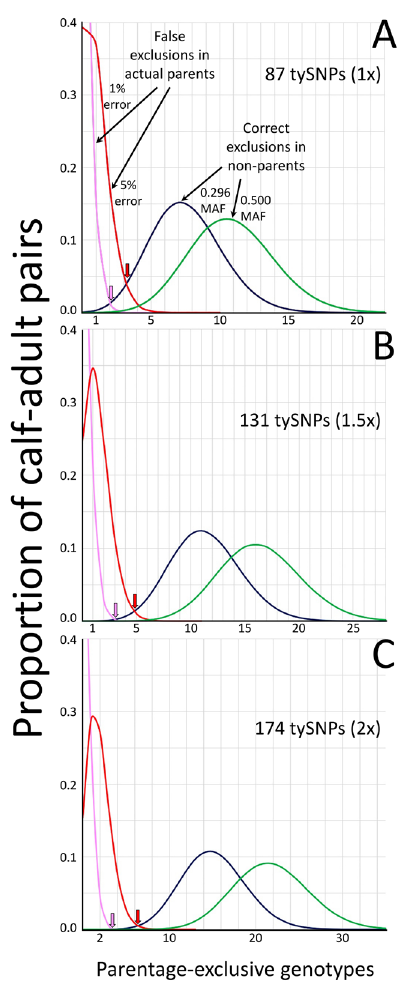
Figure 7. Simulated power for parentage exclusion with expanded tySNP sets, genotyping errors, and without the dam’s genotypes. Simulations were run as described in the Methods. Red and pink arrows point to the ambiguous overlap between correct exclusions in non-parents and the false exclusions in the actual parents at 5% and 1% genotyping error rates, respectively. (Figure7_ParentageSim4.TIF)